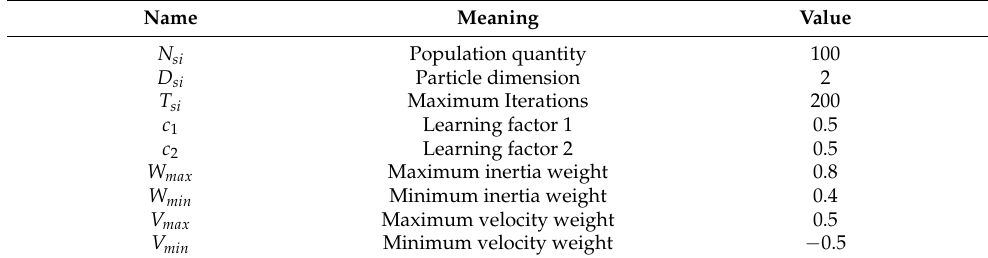
Table 3. The main parameters of the